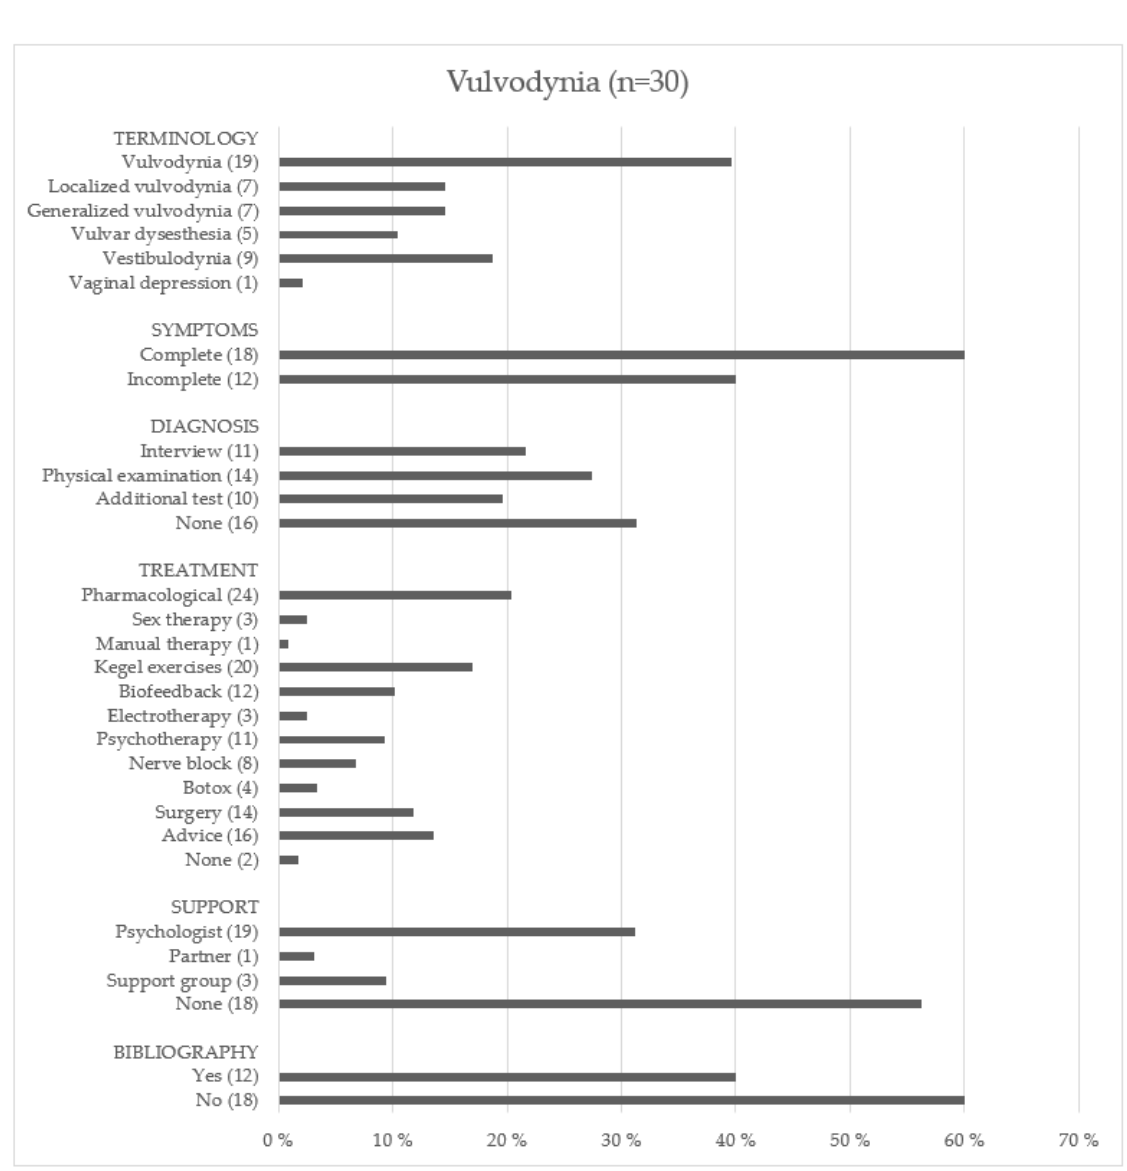
Figure 4. The type of information in websites on vulvodynia.